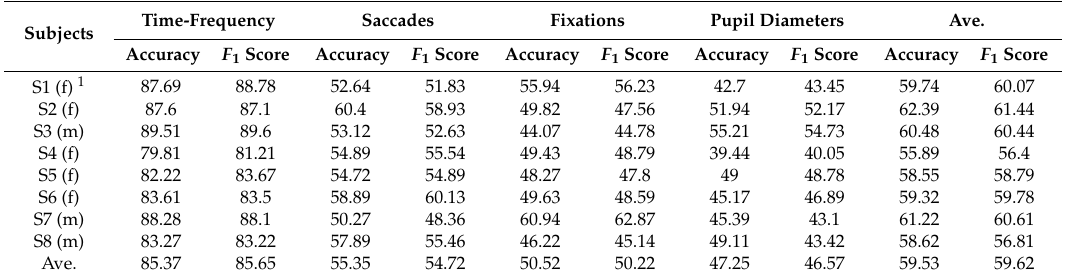
Table 2. Classification accuracies (%) and average F 1 score (%) under single feature